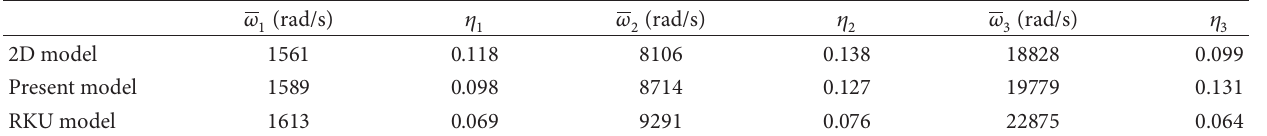
Table 4: Modal properties of the sandwich cantilever beam with 𝐻 2 = 10